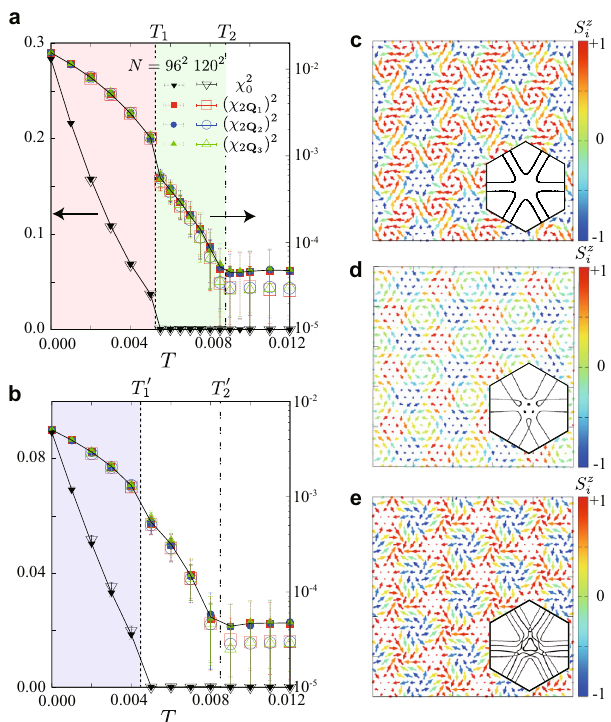
Fig. 3 Finite-temperature behaviors of the Kondo lattice model. a , b Temperature dependences of the scalar chirality, χ 2 magnetic fi eld H = 0 ( a ) and H = 0.004 ( b ). The dashed (dash-dotted) line represents the transition temperature T 1 ( T 2 ) in a and T 0 c – e Real-space spin con fi gurations in the SkX2 at T = 0 and H = 0 ( c ), the TVX at T = 0.006 and H = 0 ( d ), and the SkX1 at T = 0 and H = 0.004 ( e ). The color scale indicates S z i , while the arrows indicate ð S x i ; S y i Þ . The insets display the Fermi surfaces in each state; the sixfold rotational symmetry is broken in all the three states. See the main